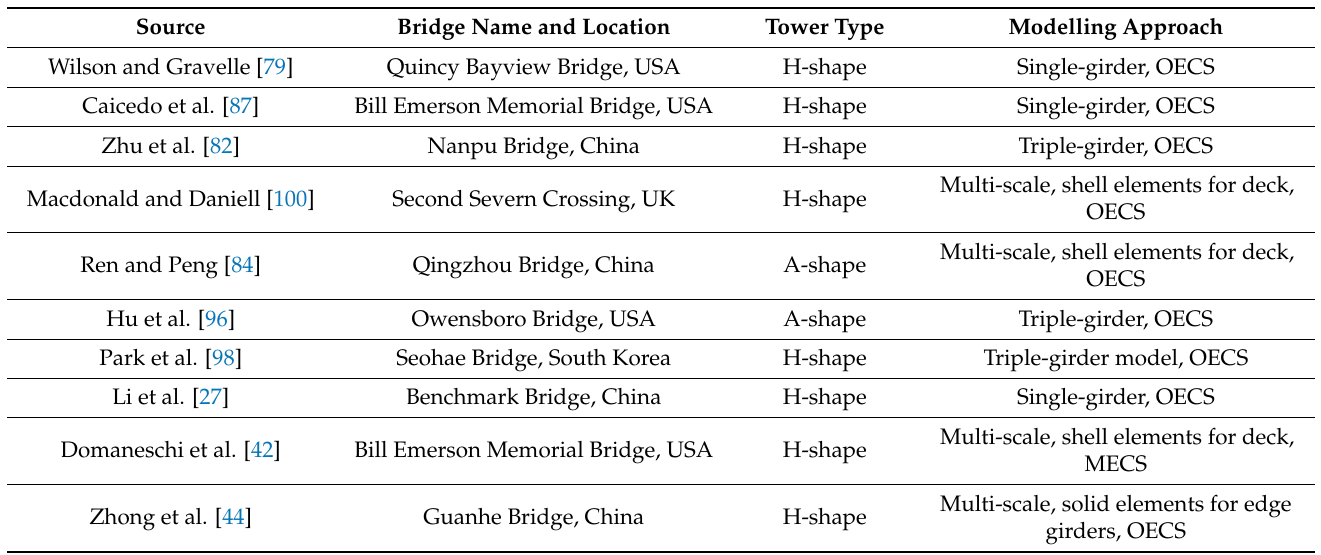
Table 2. FE modelling approaches for open section girders.